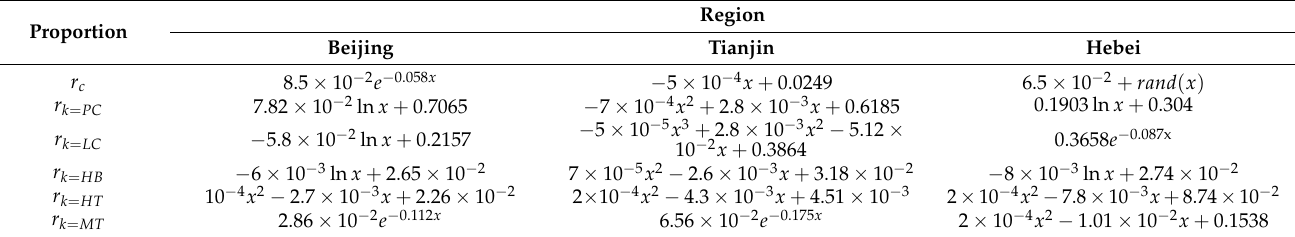
Table 2. Proportion prediction functions 1